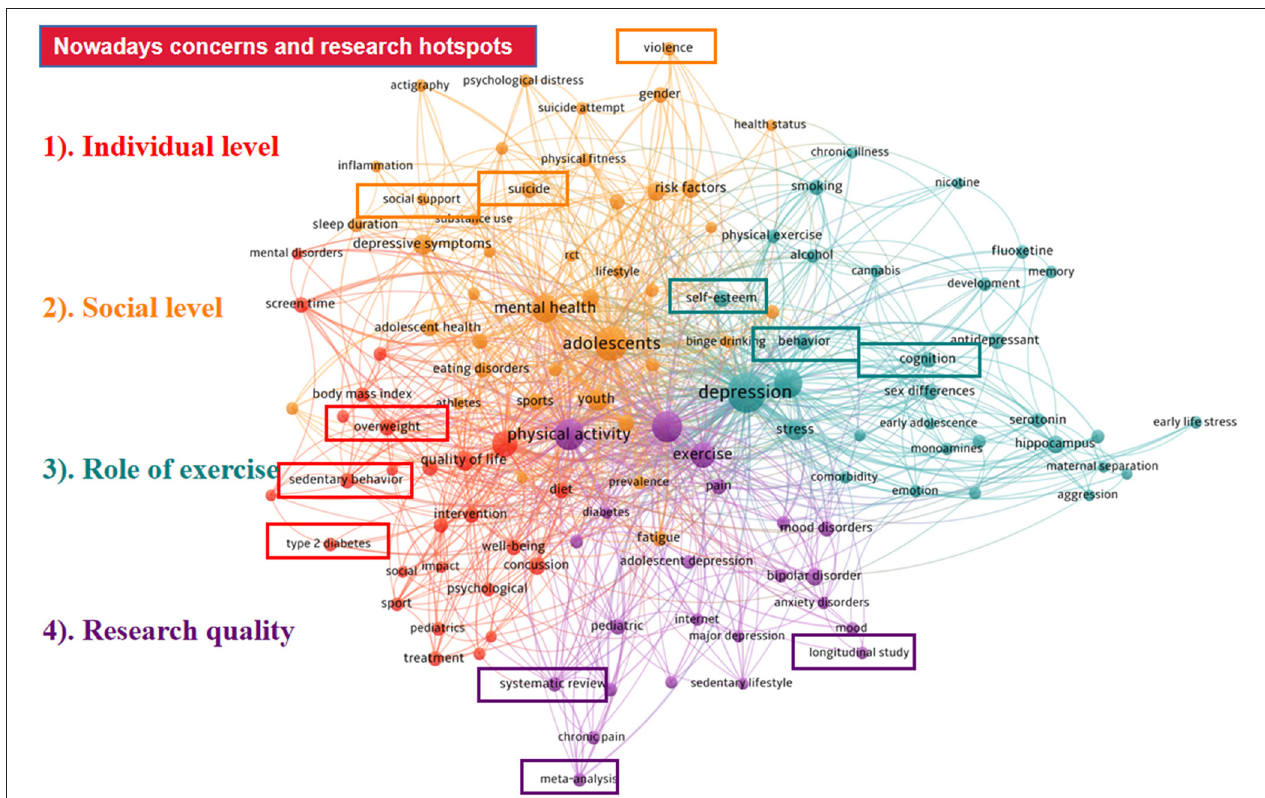
FIGURE 6 | The distribution of the co-occurrence network of keywords in exercise-depression-teenager